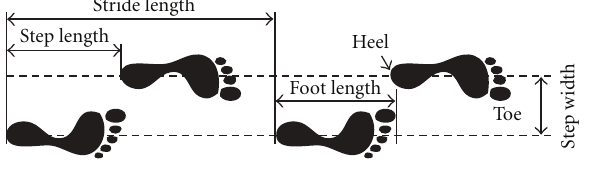
Figure 5: Gait spatial features.